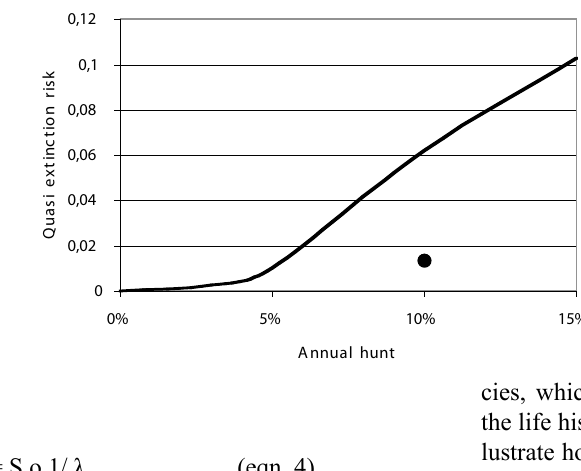
Fig. 12e. Extinction risk increases when the annual hunt increases. Here the hunt is a proportion of the popula - tion size instead of a fixed number (full line).The black dot indicates the extinction risk when 500 female seals are killed every year. The dot is a reference point that can be found in Figs 12